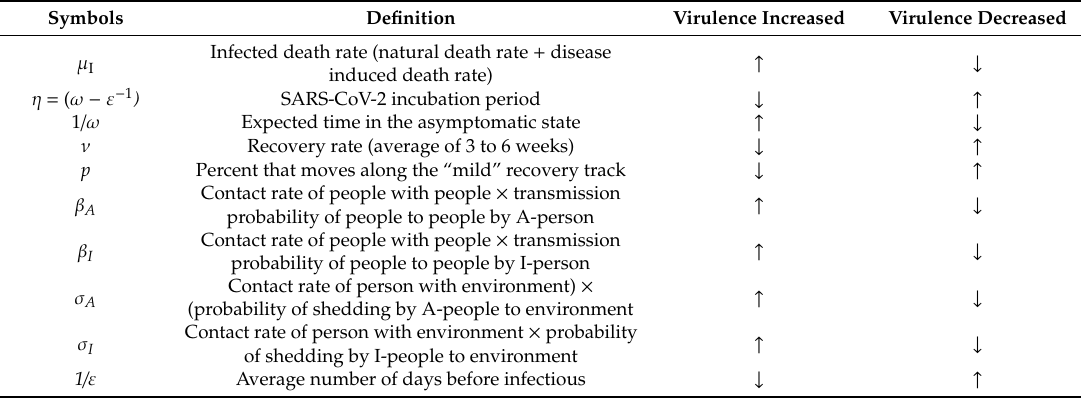
Table 3. Virulence parameters: this is a list of uniformly modulated parameters and the direction in which they change when virulence is increased or decreased. When virulence changes, an up arrow ( ↑ ) indicates the parameter is increased (by an equivalent percent) and a down arrow ( ↓ ) indicates the parameter is decreased (by an equivalent